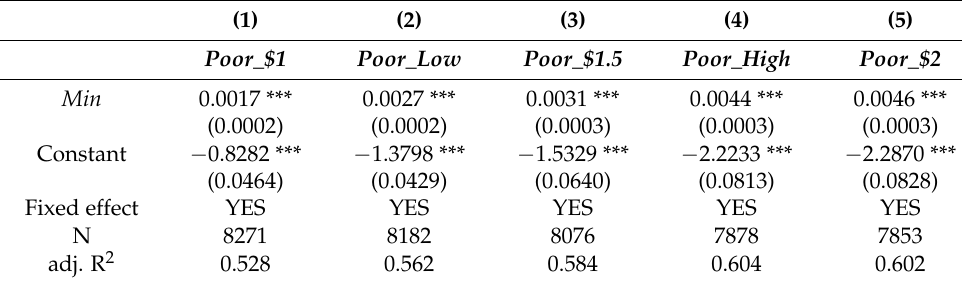
Table 10. Impact of extreme low temperature on groups with a probability of poverty greater than 0.29.